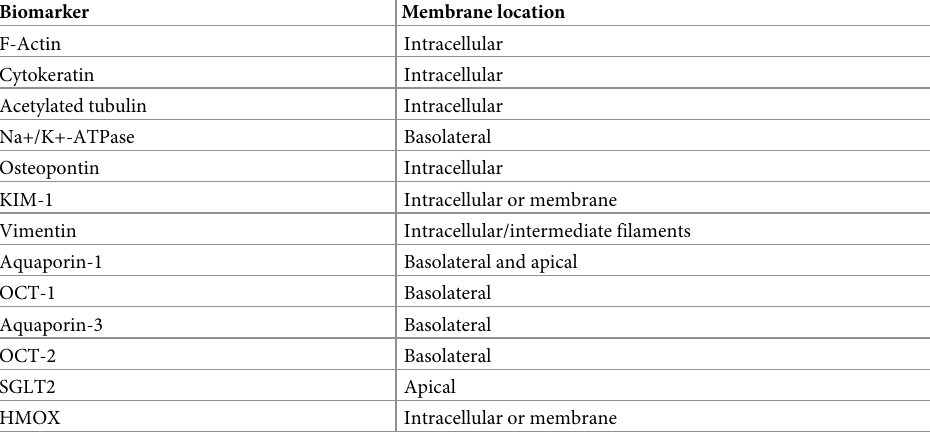
Table 2. Tubuloid biomarkers and respective membrane